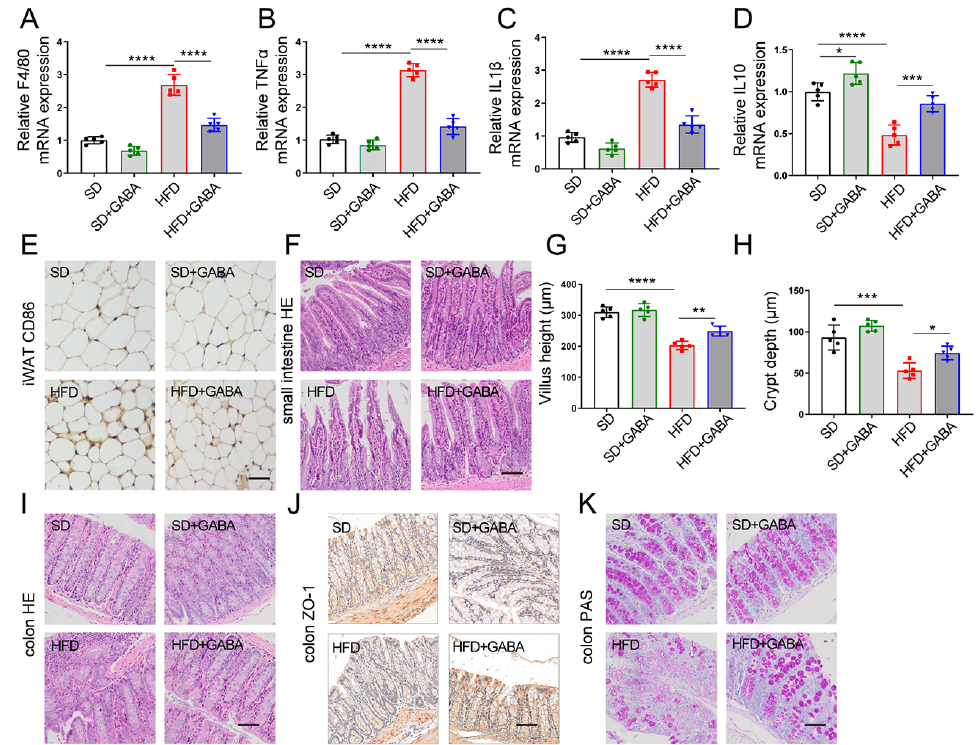
Figure 3. GABA treatment reduces fat inflammation and restored intestinal structure in HFD mice. ( A – D ) mRNA expression of inflammation-related factors (including F4/80, TNFα, IL 1β, and IL 10)